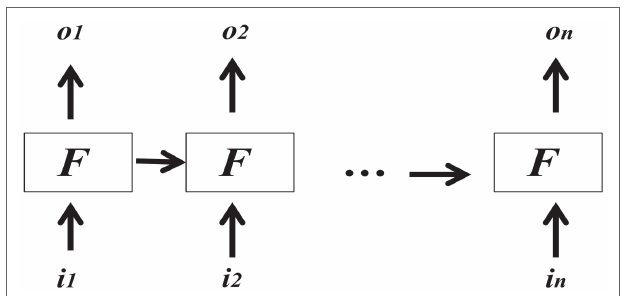
FIGURE 3 | A recurrent neural network in backpropagation modeling S R E A → S R E C